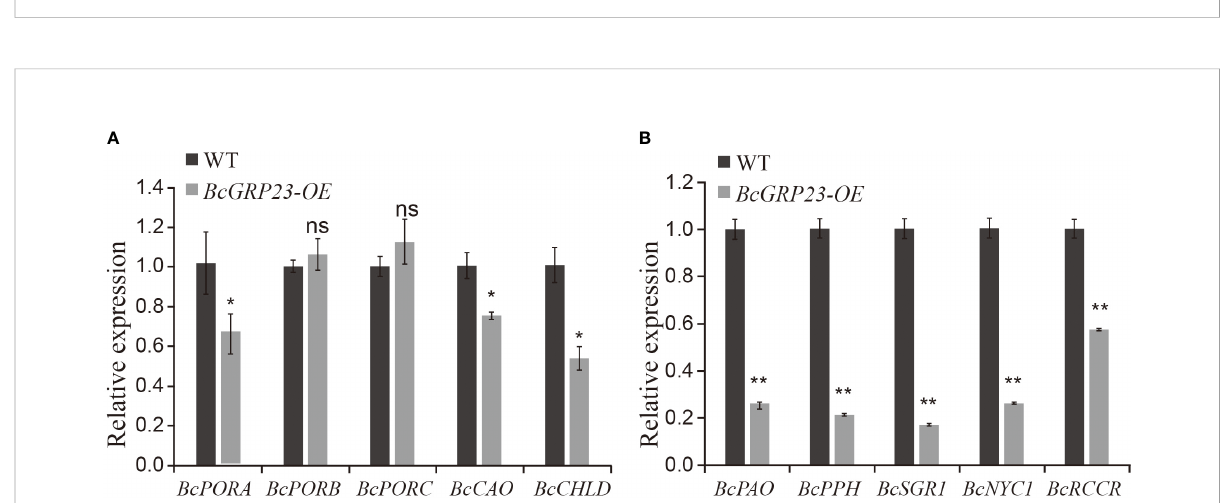
FIGURE 6 Expression of the chlorophyll biosynthesis-related (A) and degradation-related (B) genes in the petioles of BcGRP23 -overexpressing plants. *Signi fi cant difference at the p < 0.05 level; **signi fi cant difference at the p < 0.01 level; ns indicates that the difference between the two lines is not statistically signi fi cant (Student ’ s t